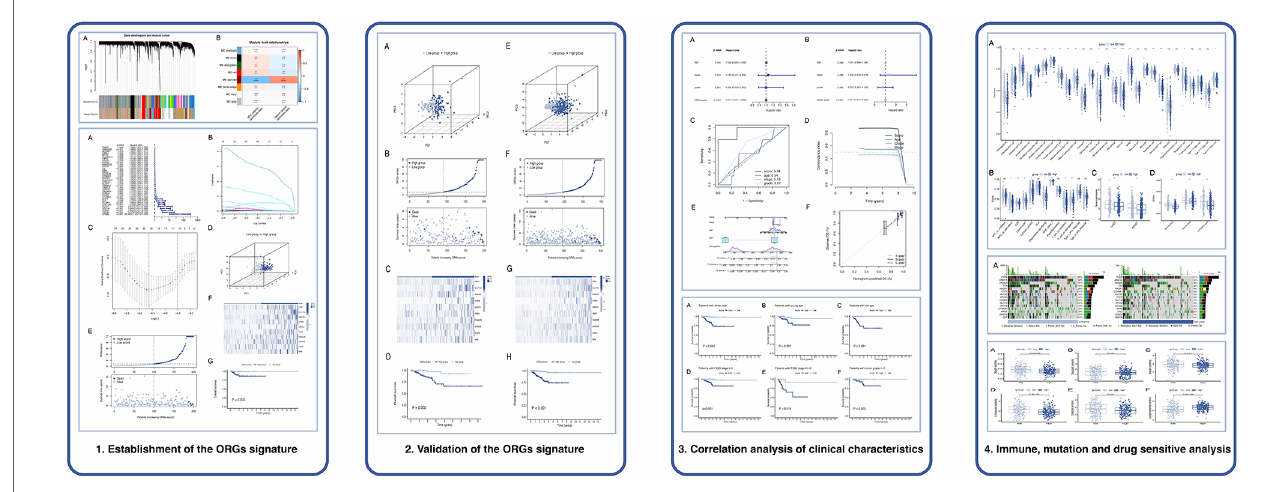
FIGURE 1 The fl ow plot of this